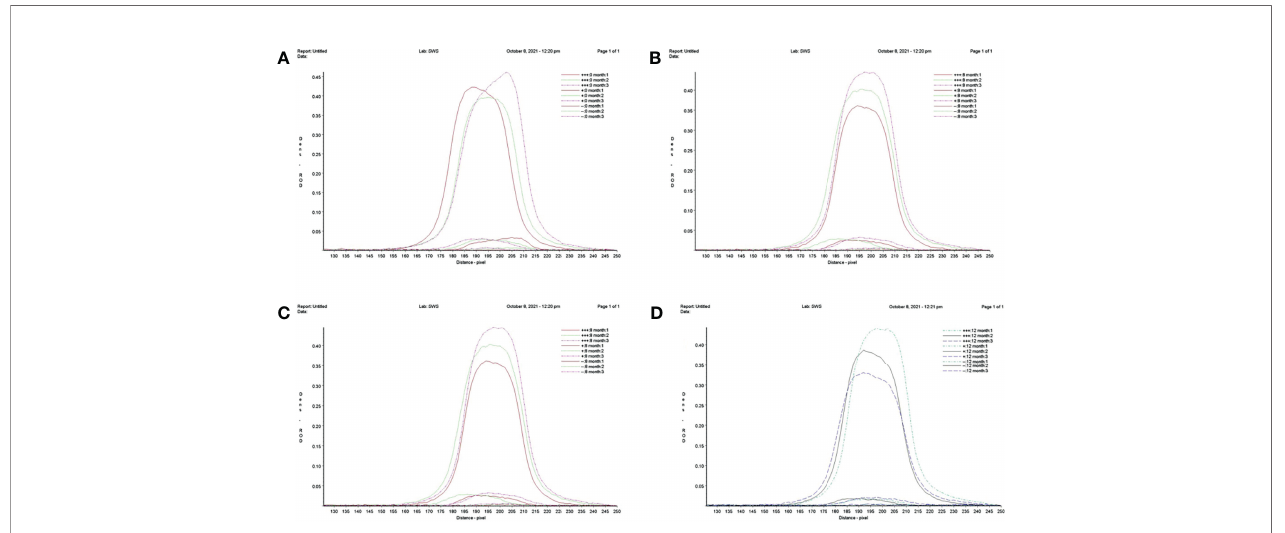
FIGURE 6 | Repeatability and stability of reverse transcription recombinase-aided ampli fi cation – lateral fl ow dipstick. (A) Screening of lateral fl ow dipstick ’ s test lines at 0 month. (B) Screening of lateral fl ow dipstick ’ s test lines at 4 months. (C) Screening of lateral fl ow dipstick ’ s test lines at 8 months. (D) Screening of lateral fl ow